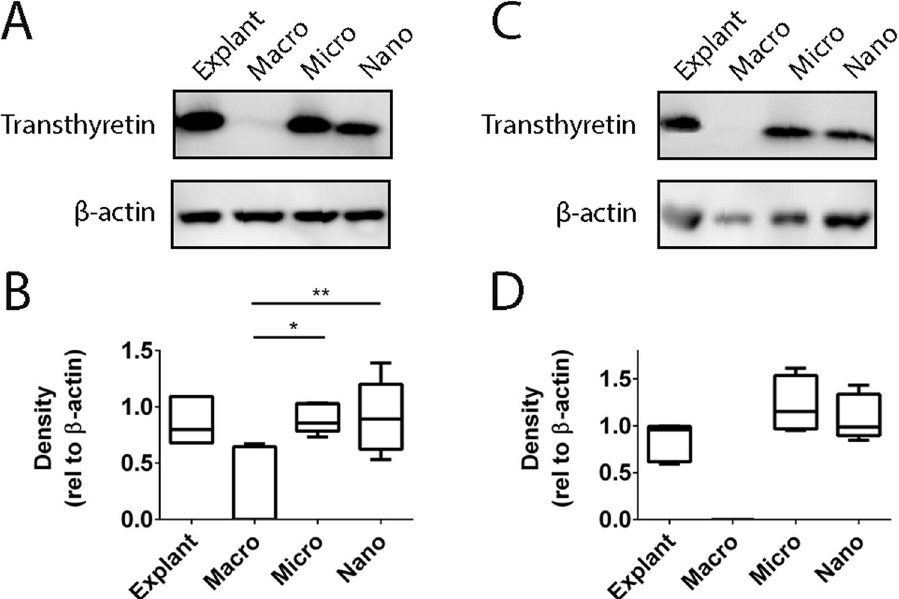
Figure 2. Transthyretin is carried by placental extracellular vesicles. Representative Western blots showing the presence of transthyretin in different fractions of extracellular vesicles extruded from first trimester and term placental explants ( A , C ). Full-length blots are presented in Supplementary Figure 2. Semi-quantitative analyses of the levels of transthyretin relative to the levels of β -actin show that there were significantly higher levels of transthyretin in micro- ( * p = 0.011, n = 5) and nano- ( ** p = 0.0099, n = 5) vesicles compared with macro- vesicles from first trimester placentae ( B ). Transthyretin was not carried by macro-vesicles from term placentae ( D ). Data is plotted as box-whisker plots showing the median, interquartile range (box) and maximum/ minimum (whiskers).